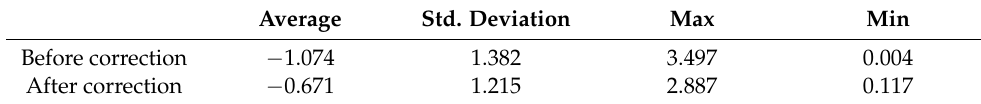
Table 4. Shape error of curve 3 according to reverse engineering (unit: mm).